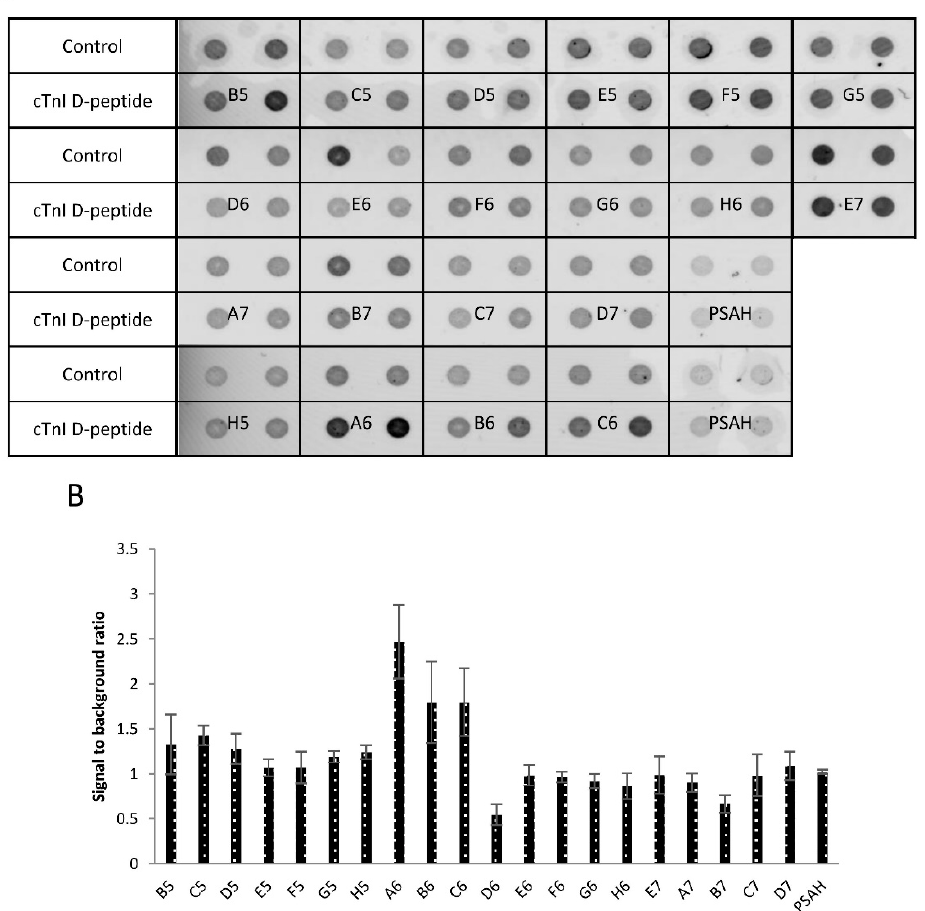
Figure 2. Screening of isolated oligonucleotides by filter binding assay. ( A ) Non-modified bead or 10 pmol of bead-bound cTnI D-peptide was incubated with 0.4 µM Cy5 labelled D-oligonucleotide solution. Following the washing steps, the beads were transferred onto nitrocellulose membrane and the fluorescence signal was detected by a fluorescence scanner. ( B ) Relative fluorescence intensities as result of the quantitative evaluation of the fluorescence